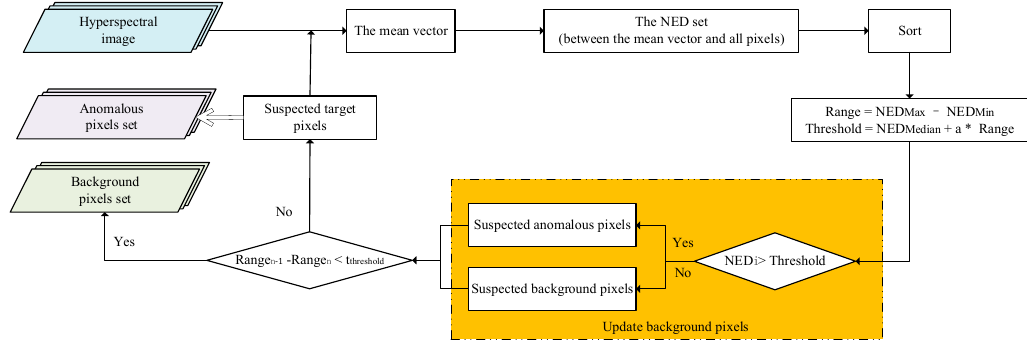
Figure 2. The flowchart of BSM.